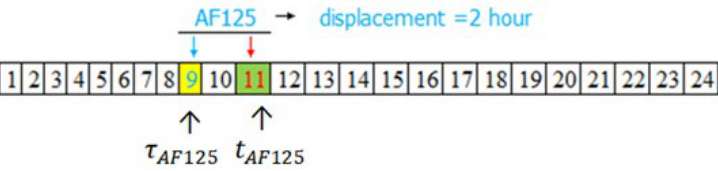
Figure 2. Displacement of τ AF125 when interval is set as an hour.